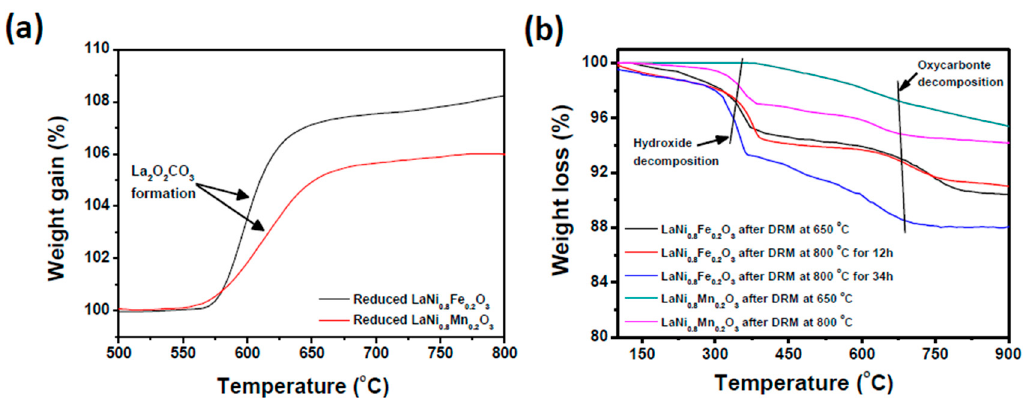
Figure 6. Thermogravimetric analysis of ( a ) reduced LaNi 0.8 Fe 0.2 O 3 and LaNi 0.8 Mn 0.2 O 3 catalysts in CO 2 atmosphere ( b ) LaNi 0.8 Fe 0.2 O 3 and LaNi 0.8 Mn 0.2 O 3 DRM samples in inert Ar atmosphere. All processes are labeled.